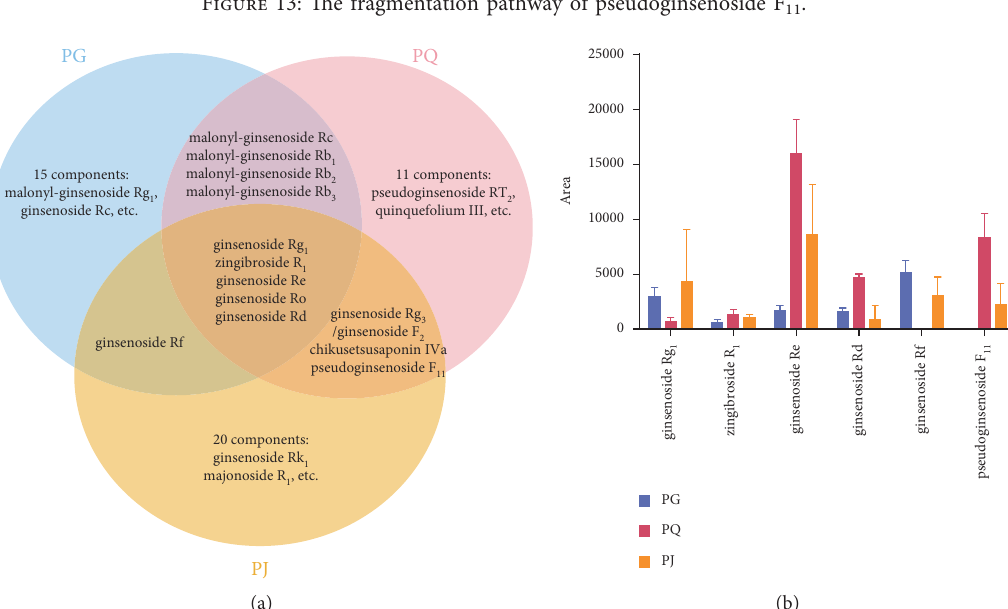
Figure 13: The fragmentation pathway of pseudoginsenoside F